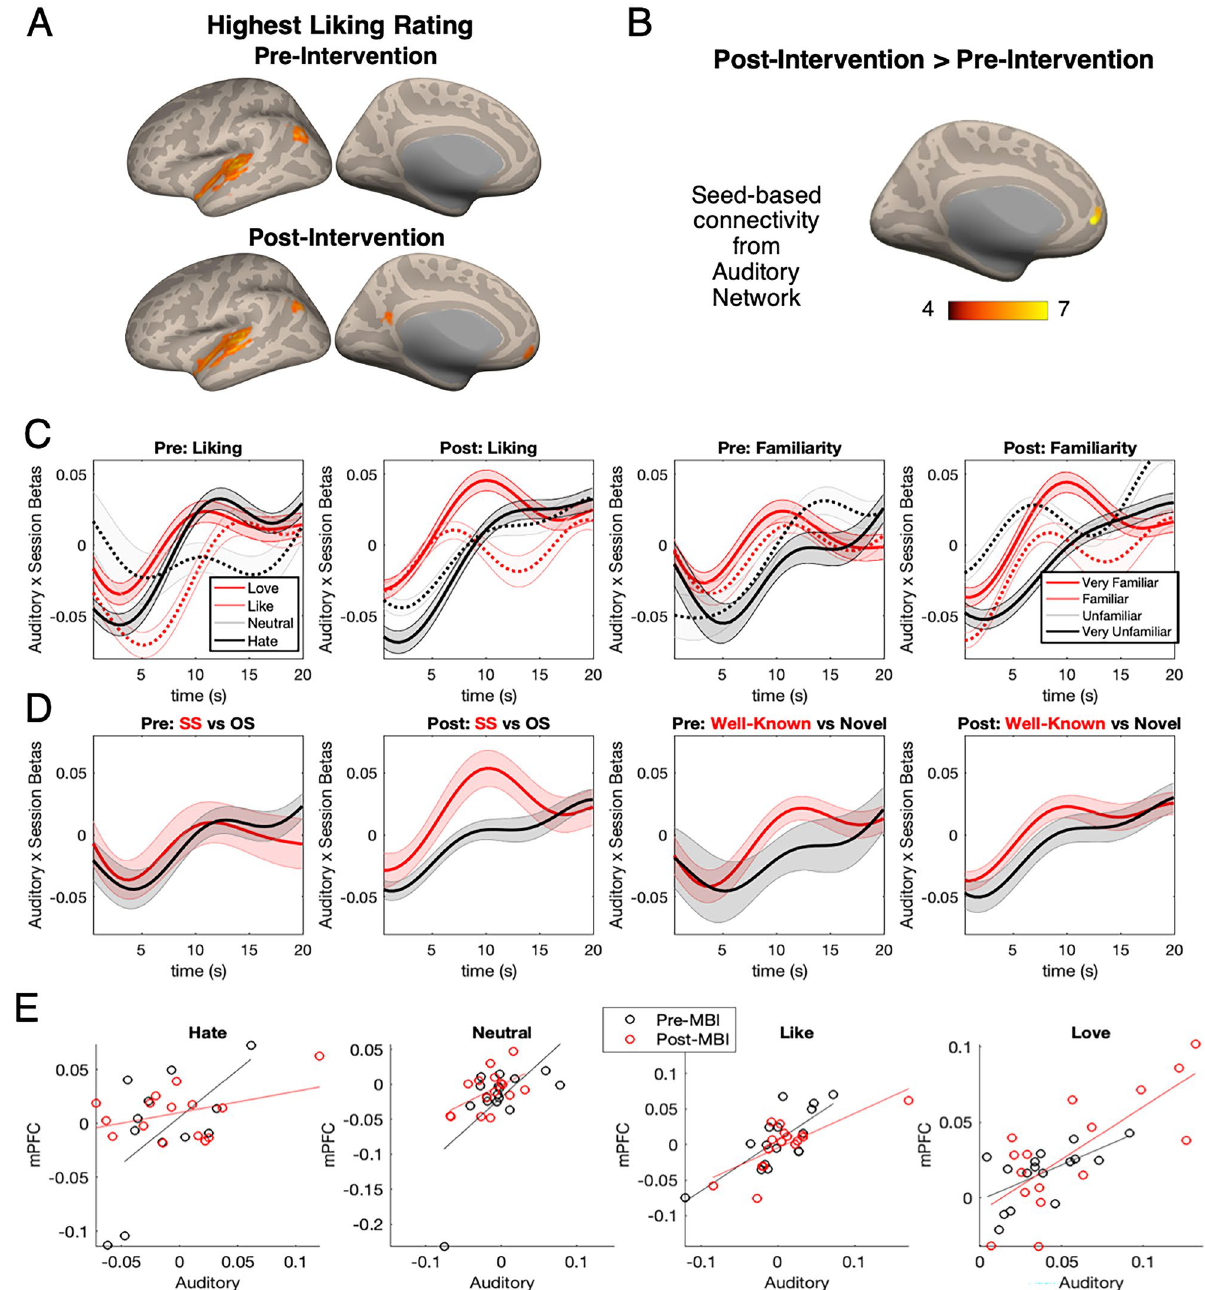
Figure 3. Seed-based connectivity from auditory ROIs. ( A ) Cortical regions active during musical stimuli that received the highest liking rating (“Love”) pre- and post-intervention, showing significant activity in mPFC post-intervention but not pre-intervention. Voxelwise and clusterwise FDR-corrected p < 0.05. ( B ) The mPFC showed a significant effect of session (post-intervention > pre-intervention) in auditory network seed-based functional connectivity (voxel height p < 0.001, uncorrected; cluster size p < 0.05, FDR corrected). ( C , D ) Time- series data of ROIs extracted from the positive contrast in ( B ), representing post > pre-intervention increase in functional connectivity. ( C ) Beta series for different liking and familiarity ratings pre- and post-intervention, showing an increase in beta post-intervention, representing increased functional connectivity between auditory regions and mPFC, for loved and very familiar music. ( D ) Beta series for self-selected and other-selected, and for well-known and novel music listening, showing an increase in auditory-mPFC functional connectivity after intervention for self-selected music but not for other-selected music. This increase in functional connectivity was not observed when comparing well-known vs. novel music listening. ( E ) Correlations between auditory and mPFC activity in beta values for the four levels of liking ratings before and after intervention. Each data point is one participant. Comparing across the panels from “Hate” (lowest liking rating) to “Love” (highest liking rating) shows more correlated auditory and mPFC activity during high liking ratings compared to low liking ratings, with the between-participant correlation being highest after the intervention for stimuli that received higher